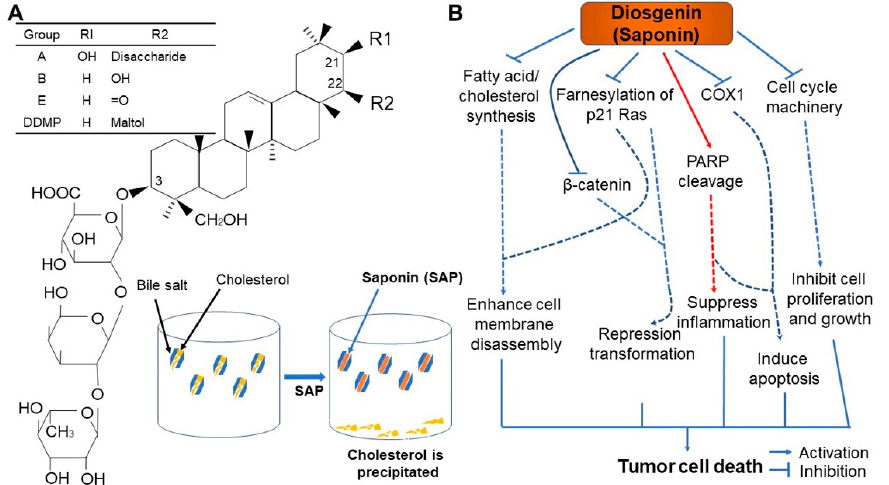
Figure 10. Chemical structure and in vitro cholesterol-lowering mechanism of saponin ( A ), and schematic representation of plausible anticancer mechanism of saponin derivatives at the cellular level ( B ) [95]. p21, a potent cyclin-dependent kinase inhibitor; β -catenin, a core component of the cadherin protein complex; COX, cyclooxygenase; PARP, poly (ADP-ribose) polymerase. → , activation; ⊥ , inactivation; --- , indirect activation. Figure adapted from Podolak, I. et al. [95].